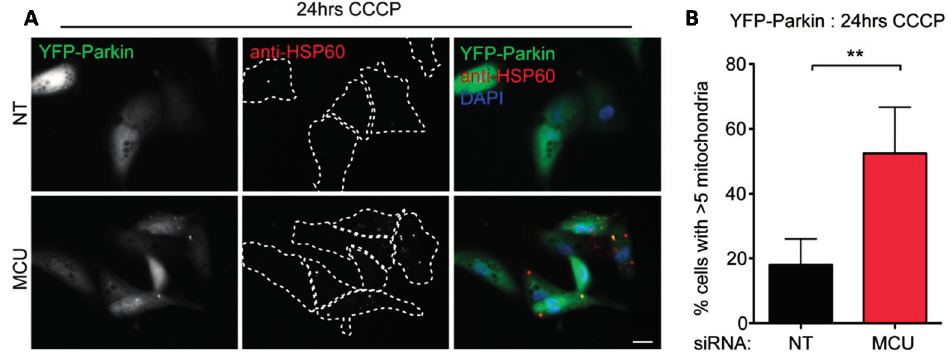
Figure 6. Silencing the mitochondrial Ca 2+ uniporter (MCU) inhibits Parkin-mediated mitophagy. Example images ( A ) and quantitation ( B ) of mitochondrial content in YFP-Parkin RPE1 cells suppressed for MCU and treated with CCCP for 24 h. ** p < 0.01, t -test. Scale bar = 10